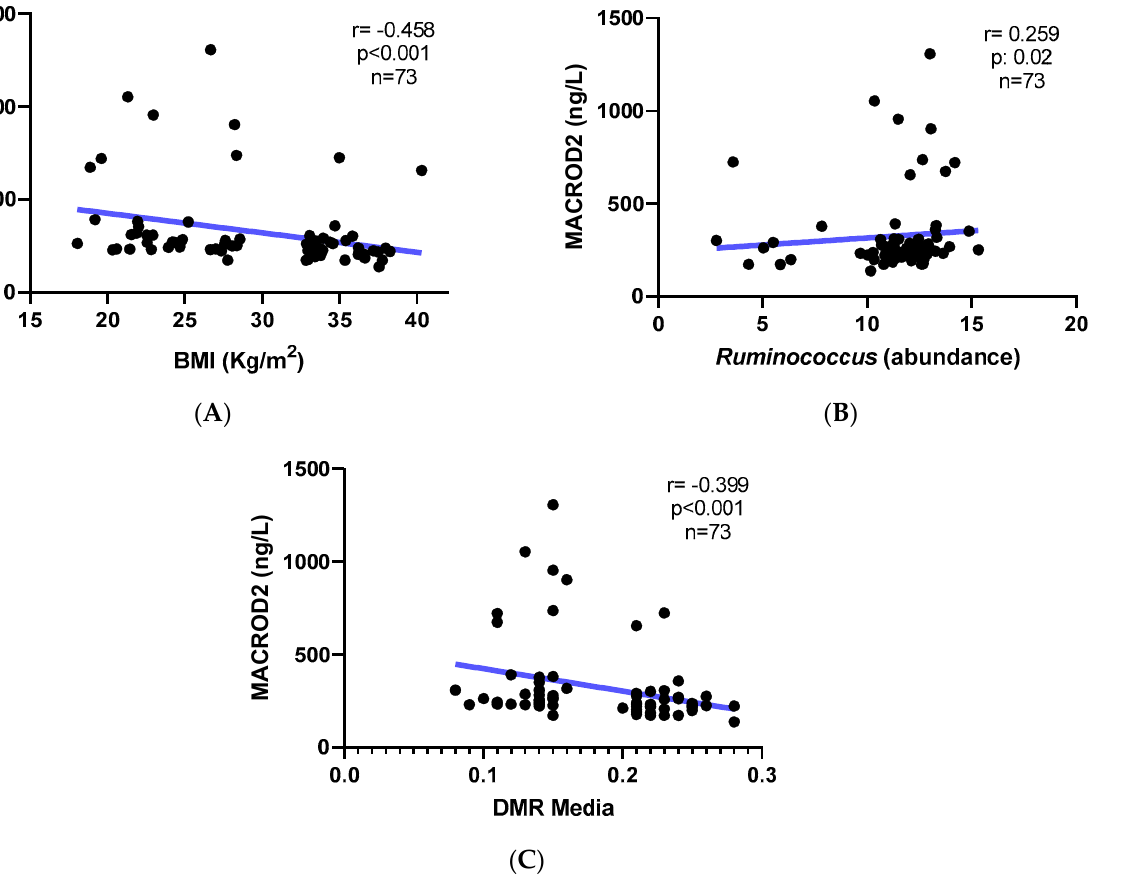
Figure 4. Correlations between MACROD2 protein levels and DMR, BMI, and bacterial abundance. ( A ) Correlation between MACROD2 protein levels (ng/L) and BMI ( n = 73 subjects). ( B ) Correlation between MACROD2 protein levels (ng/L) and Ruminococcus abundance. ( C ) Correlation between MACROD2 protein levels (ng/L) and average DMR. Dots indicate each sample analyzed. Line indicates the correlation